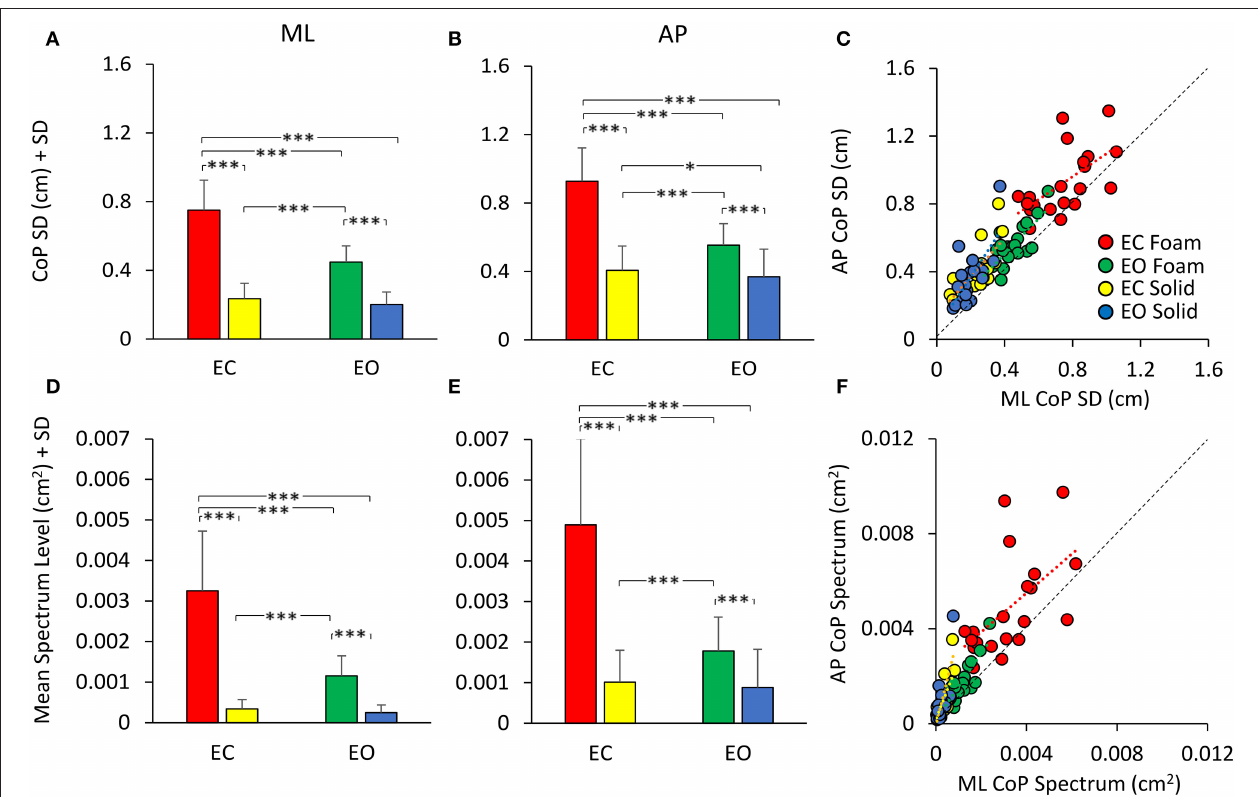
FIGURE 3 | CoP SD (top panels) and mean Spectrum Level (bottom panels). The mean CoP SDs across subjects are reported for the ML (A) and AP (B) directions for all visual (EC, red and yellow; EO green and blue) and support (Foam, red and green; Solid, yellow and blue) conditions. The mean Spectrum Level is reported for both ML (D) and AP (E) directions [same colour code as in (A,B) ]. The CoP SD and mean Spectrum Level are greater with Foam than Solid support. Vision removal affects SD and Spectrum Level mainly with Foam support (red and yellow). (C) shows the relationship between AP and ML SDs. Both CoP SDs increased with a broadly similar pattern from the more- to the less-stable conditions. (F) shows the relationship between AP and ML mean Spectrum Level. Much as for the SDs, there was a proportionality between AP and ML Spectrum Level. Each dot in C and F corresponds to a subject. Asterisks indicate significant differences (*, p < 0.05; ***, p < 0.001).